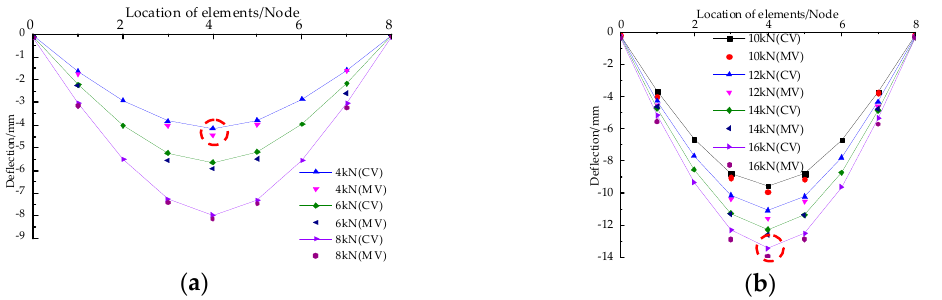
Figure 10. A comparison between MV and CV under different load levels: ( a ) Deflections with load levels 4 kN to 8 kN; ( b ) Deflections with load levels 10 kN to 16 kN.